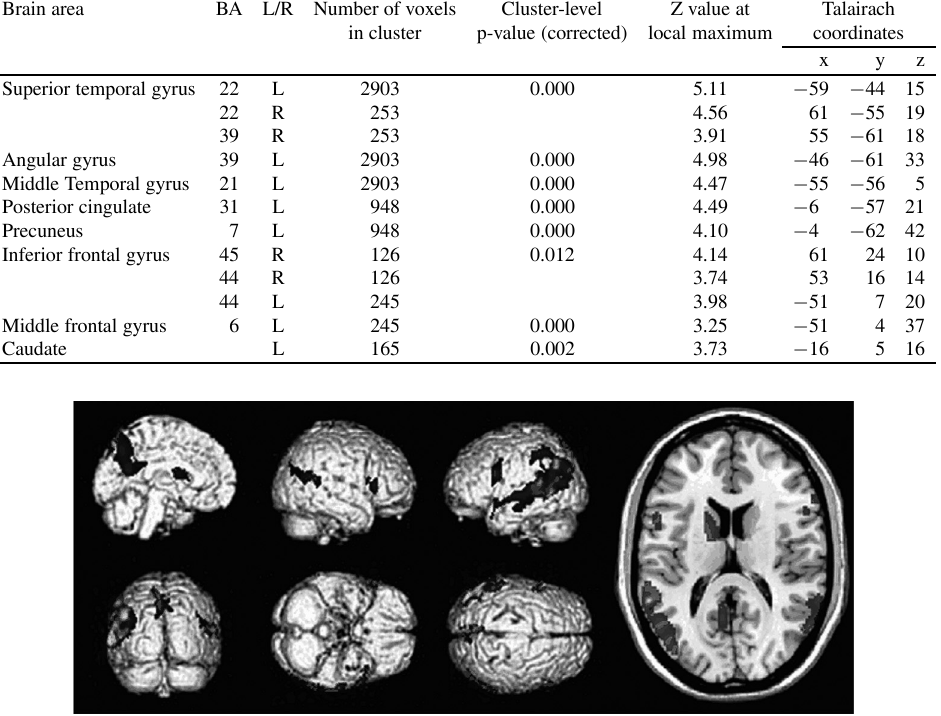
Table 2 Brain regions of decreased hypo-metabolism in the patient